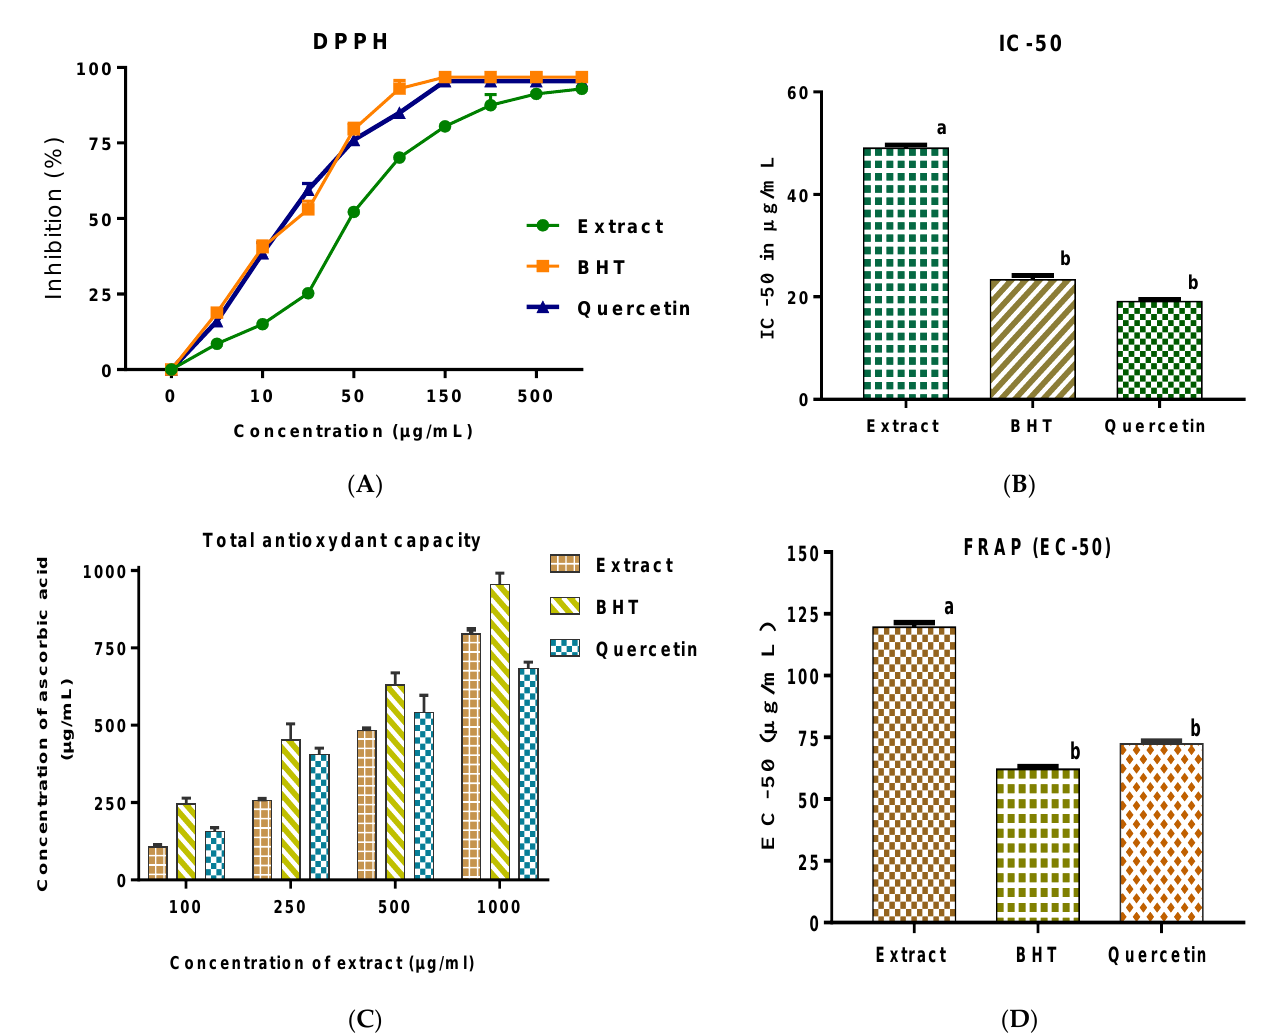
Figure 3. Antioxidant properties of crude extract of Withania adpressa Coss. ex Batt assessed by the use of DPPH ( A , B ), TAC ( C ) and FRAP ( D ) assays. Column values with the same letters are not significantly different ( n = 3, ANOVA, Tukey ’ s HSD, p -value less than 0.05 considered to be significant).